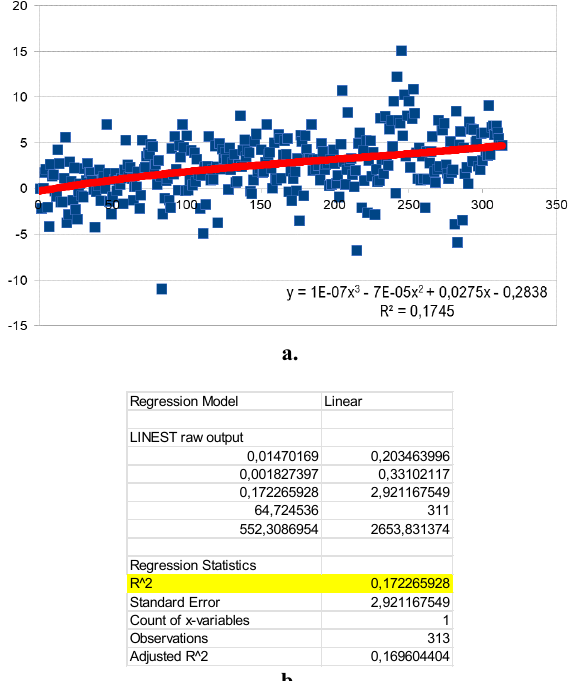
Figure 9. a. Graph of values referring to point no. 438, third- degree polynomial curve, equation and its regression. b. Linear regression referring to point no. 438.